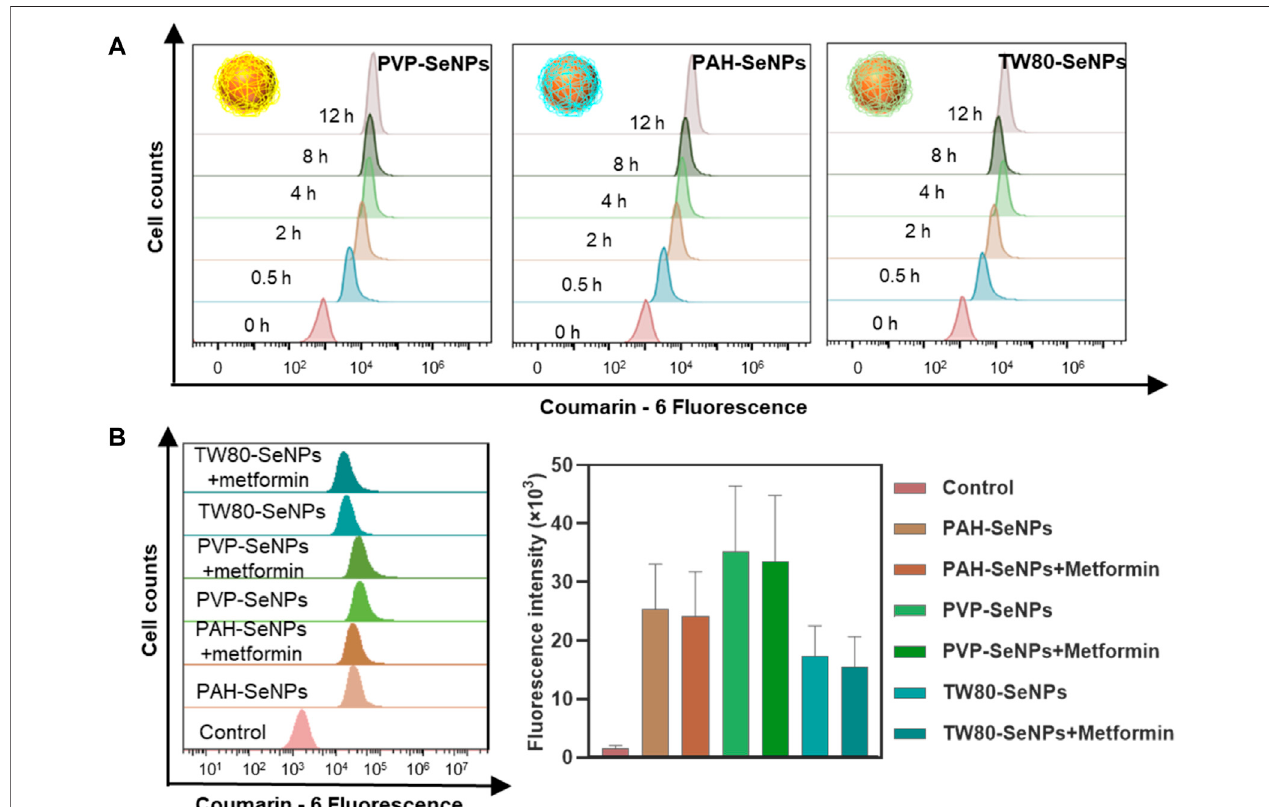
FIGURE3| Cellular uptake offunctionalizedSeNPsbyMCF-7cells. (A) Cellular uptake offunctionalizedSeNPs inMCF-7 cells. (B) The fl owcytometricresultsand statistical graphs of the cellular uptake of functionalized SeNPs in MCF-7 cells with the presence of metformin.